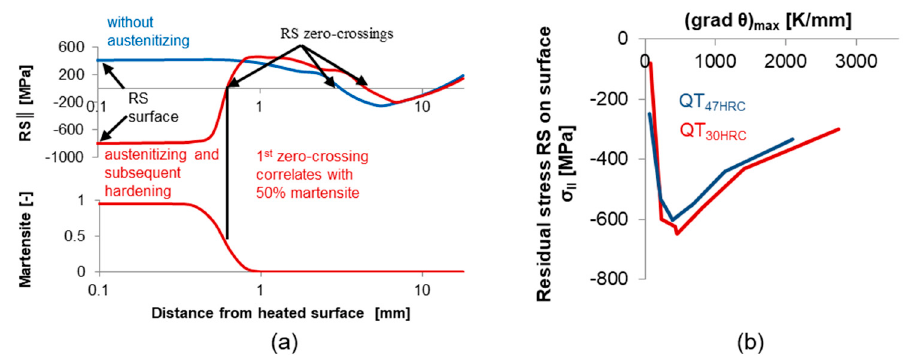
Figure 2. ( a ) Typical residual stress profiles after interaction of thermally dominated processes and the target quantities of the considered material modifications. ( b ) The correlation of the maximal thermal gradient and the residual stress at the surface in case of grind hardening of two initial quenched and tempered states of AISI4140.